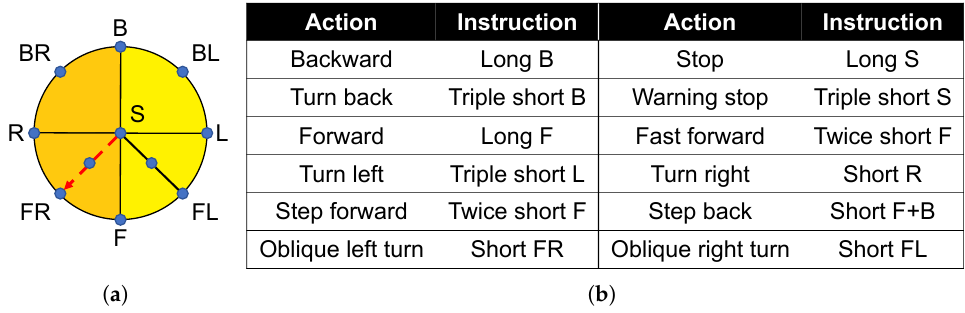
Figure 8. Oblique left turn was used as an example for the navigation coding of the oblique left Turn. ( a ) Stereo perception of the oblique left turn command in the head. ( b ) Navigation codes corresponding to head devices.